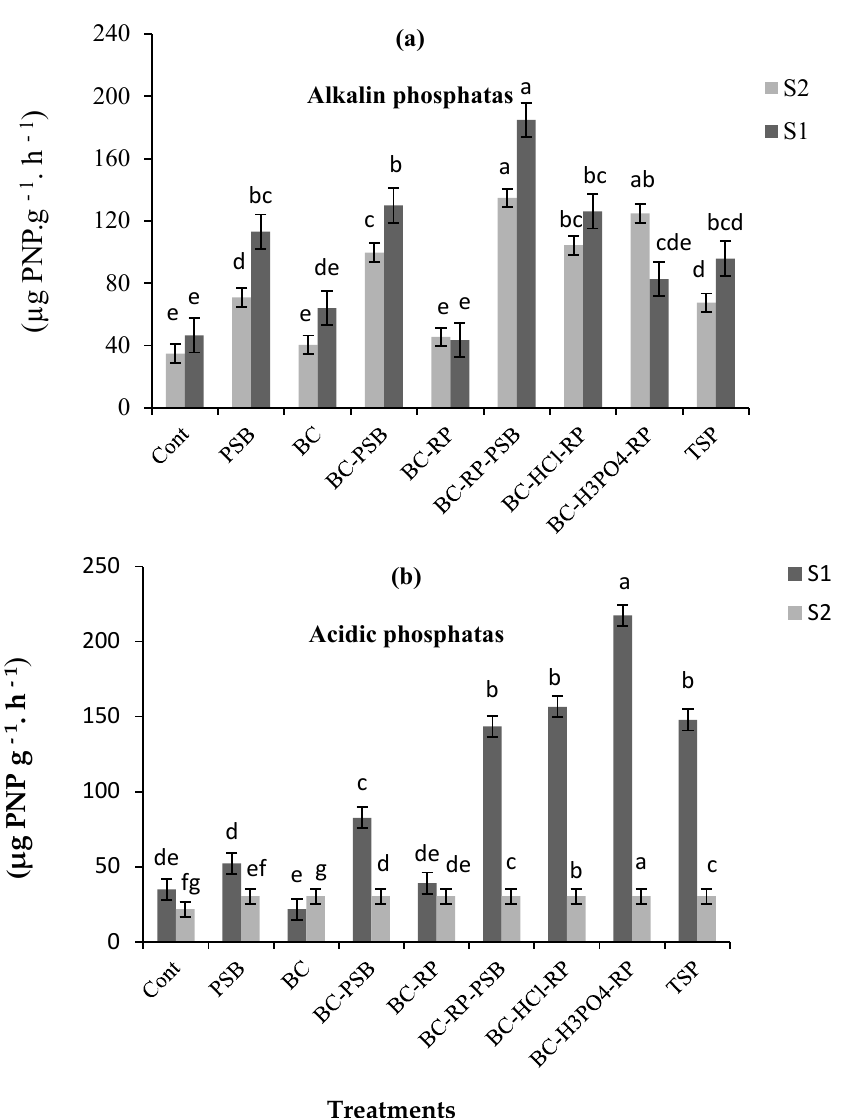
Figure 5. Effect of different treatments on phosphatase activity of soils, ( a ): alkaline phosphatase (AlP) and ( b ) acidic phosphatase (AcP), respectively. PSB: phosphate solubilizing bacteria, BC: biochar, BC-PSB: biochar with phosphate solubilizing bacteria, BC-RP-PSB: biochar enriched with PSB and RP, BC-HCl-PSB: biochar enriched with HCl-RP, BC-H 3 PO 4 -RP: biochar enriched with H 3 PO 4 -RP, TSP: triple super phosphate, Cont: control. Means with similar le tt ers are not signi fi cantly dif- ferent at 1% probability level according to LSD test. Error bars are standard deviation of the means ( n = 3), S1 and S2: soil 1 with EC = 2 dS.m − 1 and soil 2 with EC = 15 dS.m − 1 , respectively.